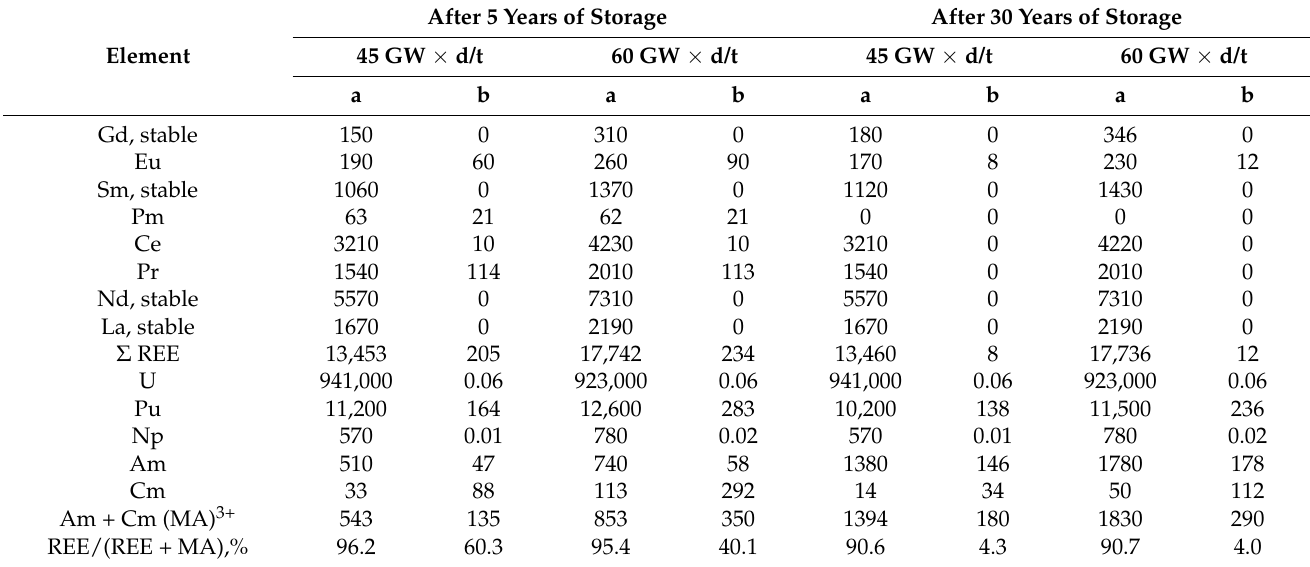
Table 1. (a) Composition (g/t) and (b) heat release (W/t) of SNF from light water reactors (LWR) depending on fuel burn and storage time